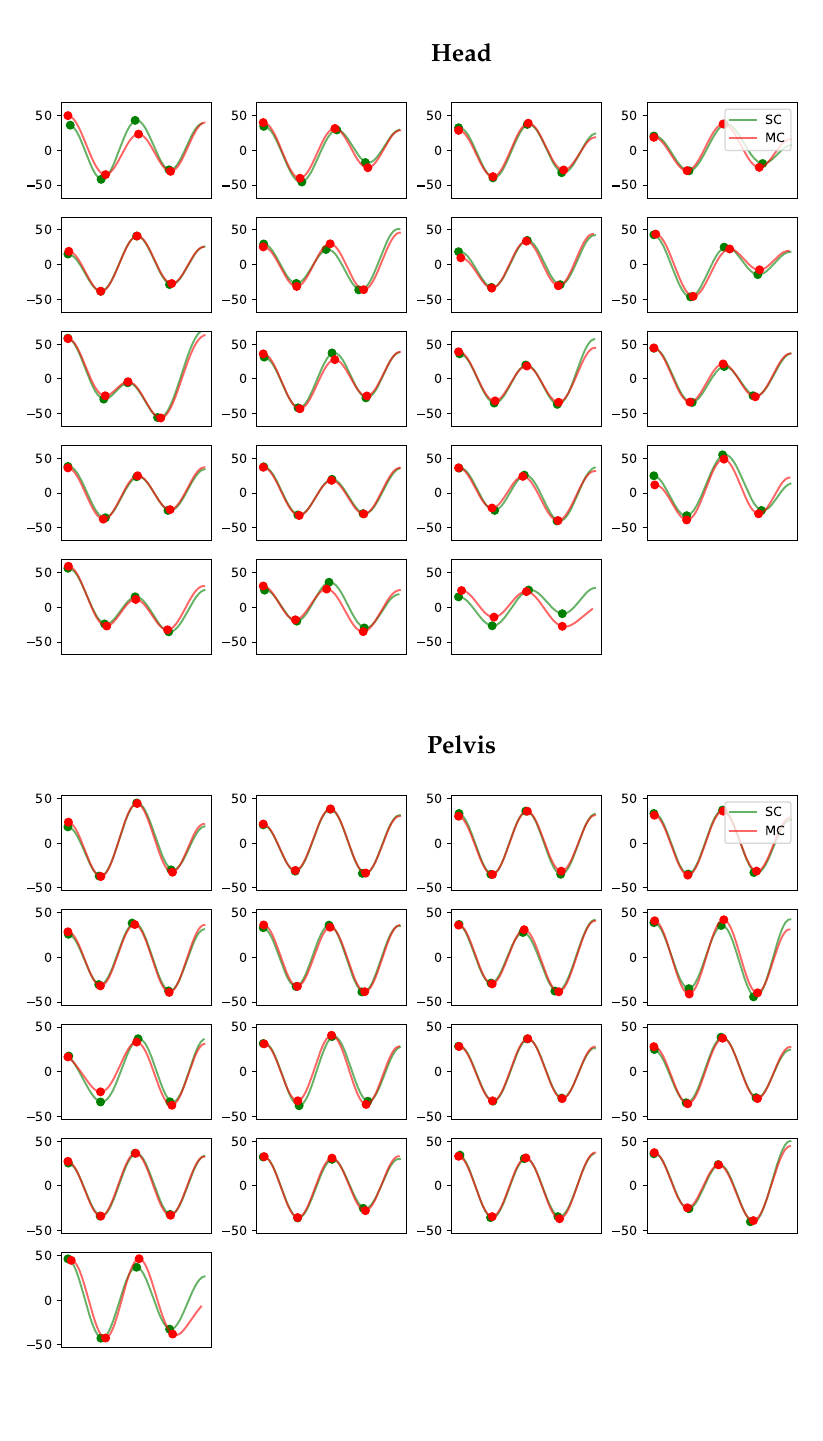
Figure A7. Vertical displacement signals per stride for the head and pelvis for horse 7. Each subplot contains the matched stride segments for the single-camera markerless system (SC) in green and the multi-camera marker-based system (MC) in red. The y-axis shows the vertical displacement in millimeters. The four dots on each curve indicate the positions of the two peaks and two valleys extracted using the approach in Section